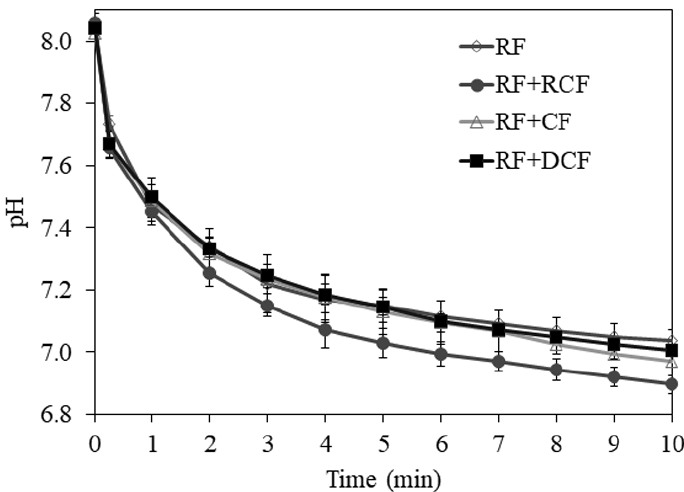
Figure 3. pH drop during in vitro protein digestion of breads (RF, rice flour; RCF, roasted chickpea flour; CF, raw chickpea flour; DCF, dehulled chickpea flour).